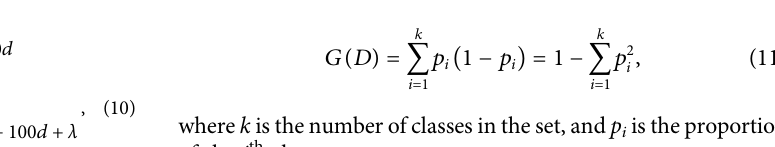
FIGURE 3 | Parameter effects on CART with different types of features. Parameters of features are scanned (A) . k -mer features (B) ; mismatch features (C) ; subsequence features (D) ; PseDSSPC features. In (A) and (B) , the vertical axis is the accuracy in leave-one-out cross-validation. In (C,D) , the heat color represents the accuracy in leave-one-out cross-validation. The optimized parameter is k = 5 for the k -mer features, k = 2 and m = 1 for the mismatch features, k = 2 and δ = 0.9 for the subsequence features, and d = 5, λ = 5, and w = 0.5 for the PseDSSPC features.